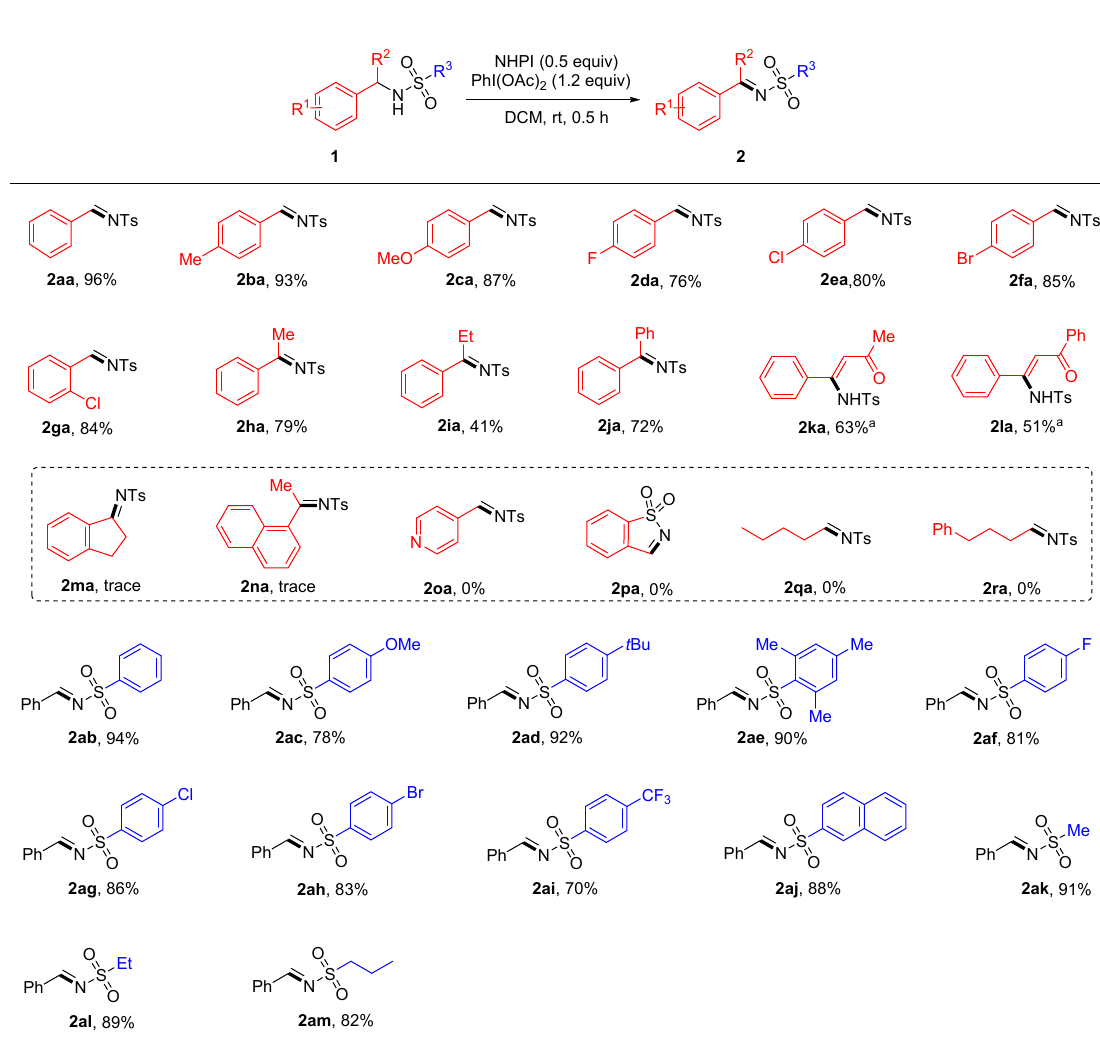
Figure 3. NHPI-mediated oxidation of sulfonamides to N -sulfonylimines. Reaction conditions: 1 (0.5 mmol), NHPI (0.25 mmol), PhI(OAc) 2 (0.6 mmol), DCM (1.0 mL), rt, 0.5 h. [a] 1.0 equiv. NHPI, 2.0 equiv. PhI(OAc) 2 .